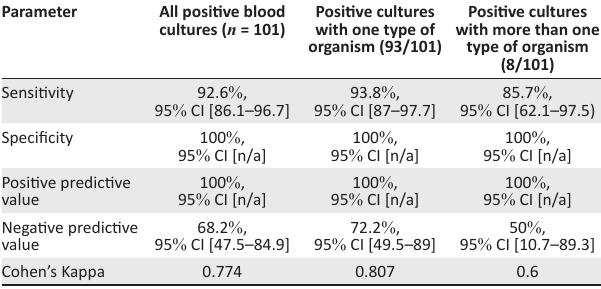
FIGURE 1: Comparison of blood culture results using combination methods against FilmArray. TABLE 1: Performance characteristics of FilmArray compared to combination